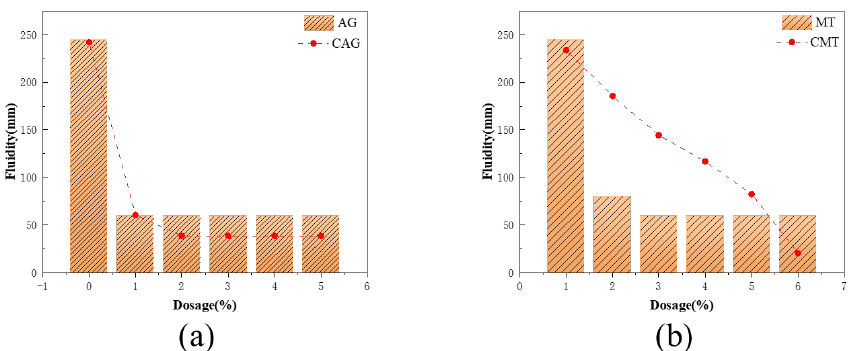
Figure 6. Effects of different contents of attapulgite and montmorillonite on the fluidity of cement paste before and after calcination: ( a ) attapulgite; ( b ) montmorillonite.